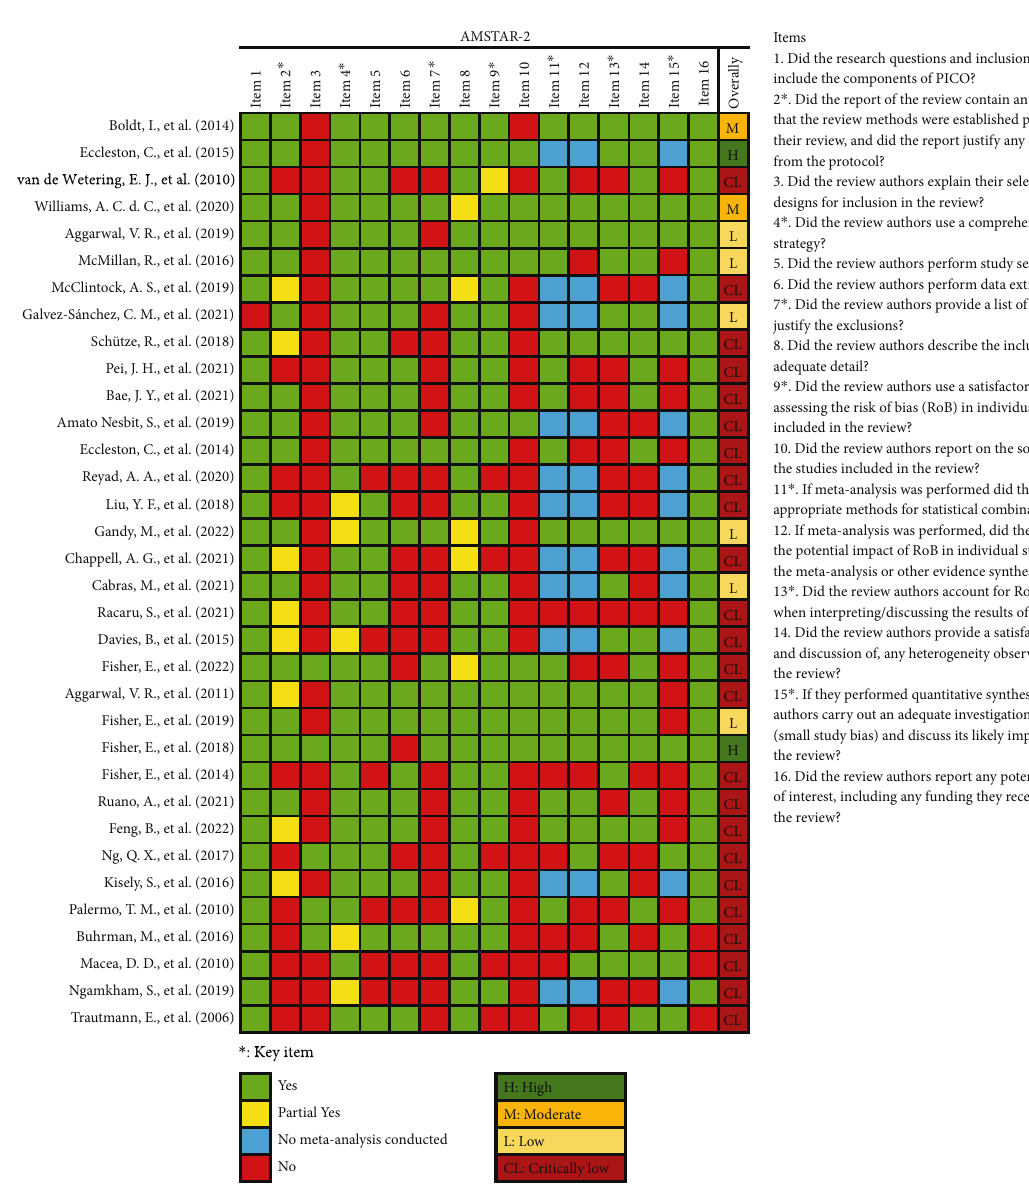
Figure 3: Methodological quality of the included systematic